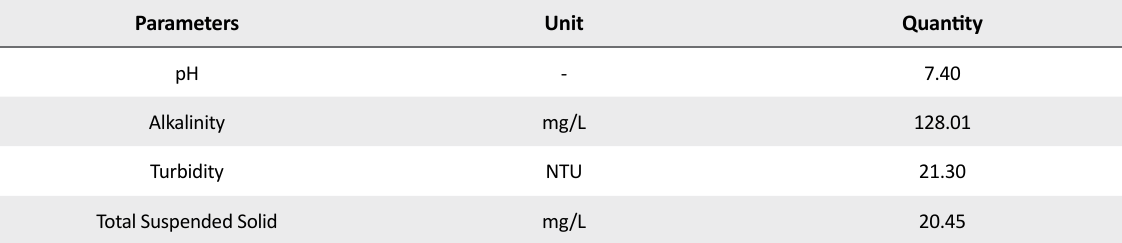
Table 4. The quality of the treated water before the filtration process